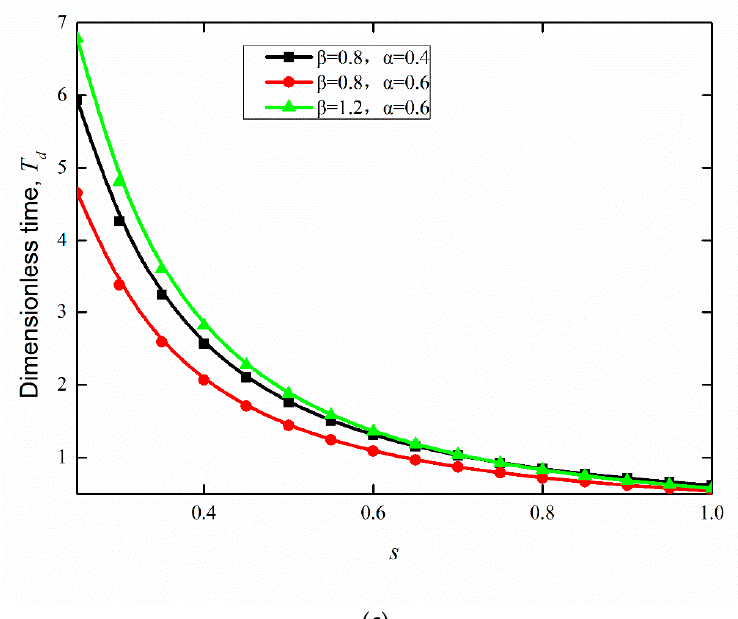
Figure 4. Dimensionless time curves of capillary flow at n = 3. ( a ) The curve of change with radius ratio α at different s values, ( b ) curve of change with length ratio β at different s values, ( c ) curve of change with radius s values at different radius ratios α and length ratios β .